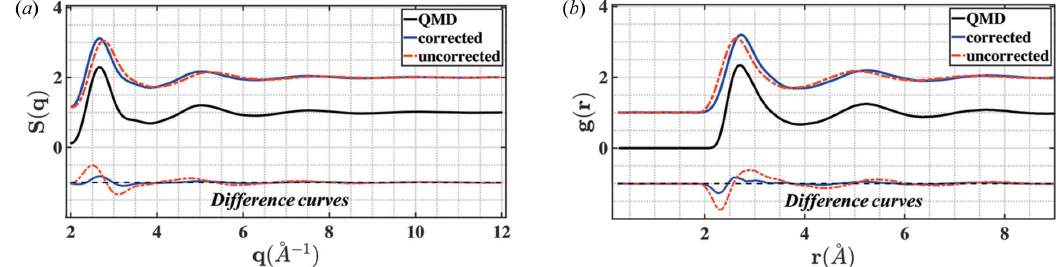
Figure 3 ( a ) Structure factor and ( b ) radial distribution function for tin derived from QMD simulations at 11.0 g/cc and 5000 K. The finite size of the QMD simulation cell results in structure factors below (cid:2) 2 A˚ (cid:5) 1 being unreliable. The difference curve of the corrected and uncorrected curves with the QMD results is shown as well.